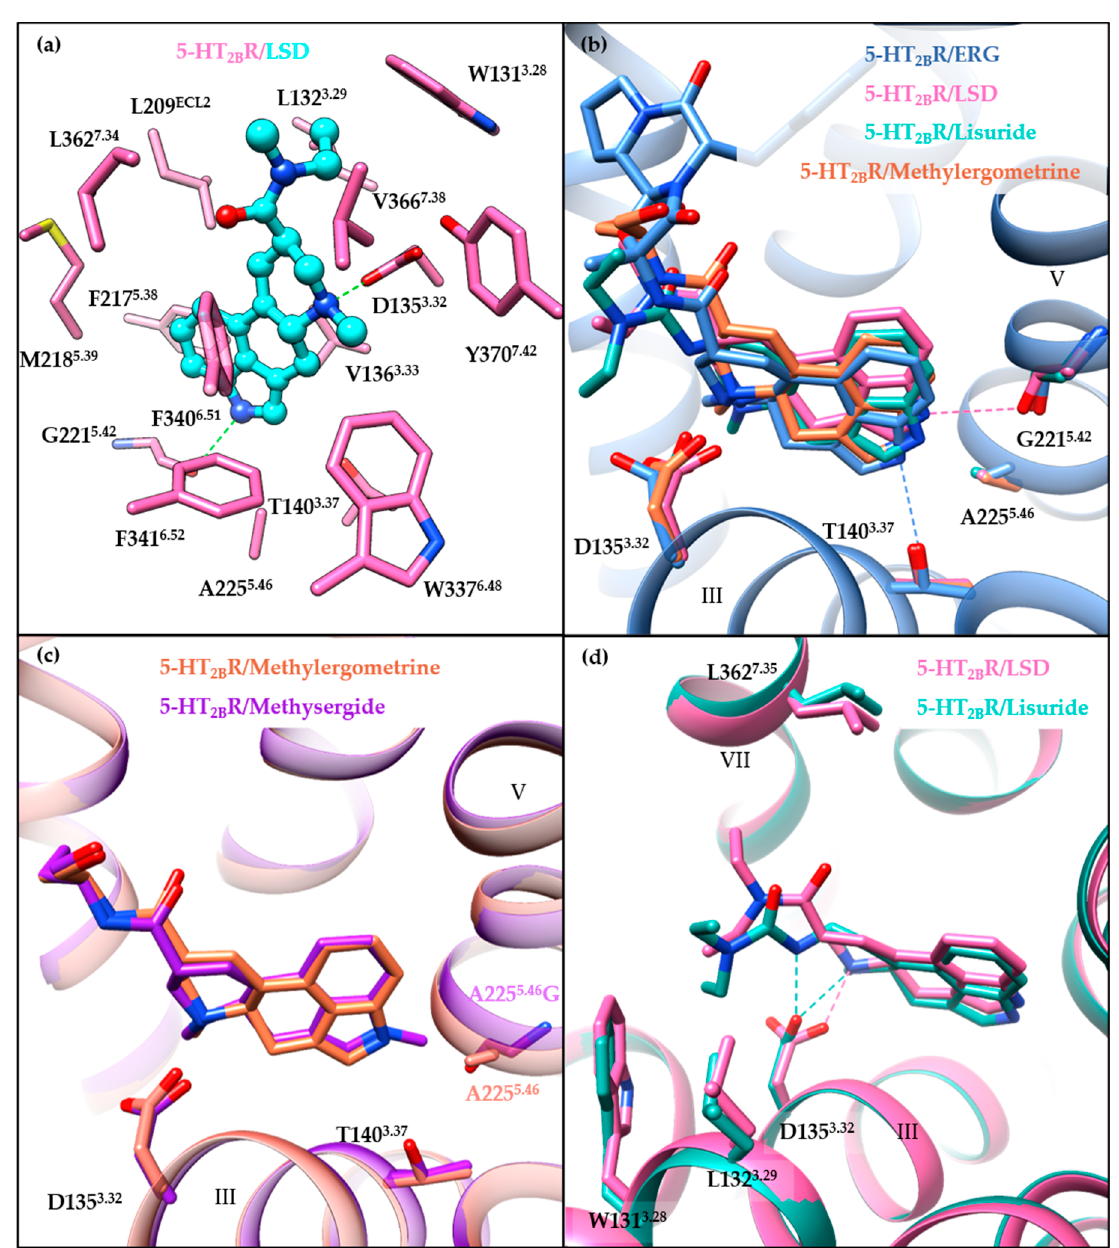
Figure 4. Overview of receptor–ligand interactions in the binding pocket. ( a ) Receptor–ligand interactions in the binding pocket of the 5-HT 2B R/LSD structure (PDB ID: 5TVN). Residues of the 5-HT 2B R are colored in hot pink, and LSD is colored in cyan. ( b ) A comparison of the specific interactions in the OBP of ergoline ligand-bound structures: 5-HT 2B R/ERG (cornflower blue, PDB ID: 4IB4), 5-HT 2B R/LSD (hot pink, PDB ID: 5TVN), 5-HT 2B R/lisuride (light sea green, PDB ID: 6DRX), and 5-HT 2B R/methylergometrine (salmon, PDB ID: 6DRY). For clear visualization, only the backbone of 5-HT 2B R/ERG is shown as a ribbon cartoon. The hydrogen bond interactions are displayed as dashed lines. ( c ) Comparison of the binding mode of the 5-HT 2B R/methylergometrine (salmon, PDB ID: 6DRY) and the A225 5.46 G mutant 5-HT 2B R/methysergide (purple, PDB ID: 6DRZ) structures. ( d ) Comparison of the specific interactions in the EBP of the 5-HT 2B R/LSD (hot pink, PDB ID: 5TVN) and the 5-HT 2B R/lisuride structures (light sea green, PDB ID: 6DRX). Hydrogen bond interactions are shown as dashed lines. Molecular images were generated using the UCSF Chimera software [115].